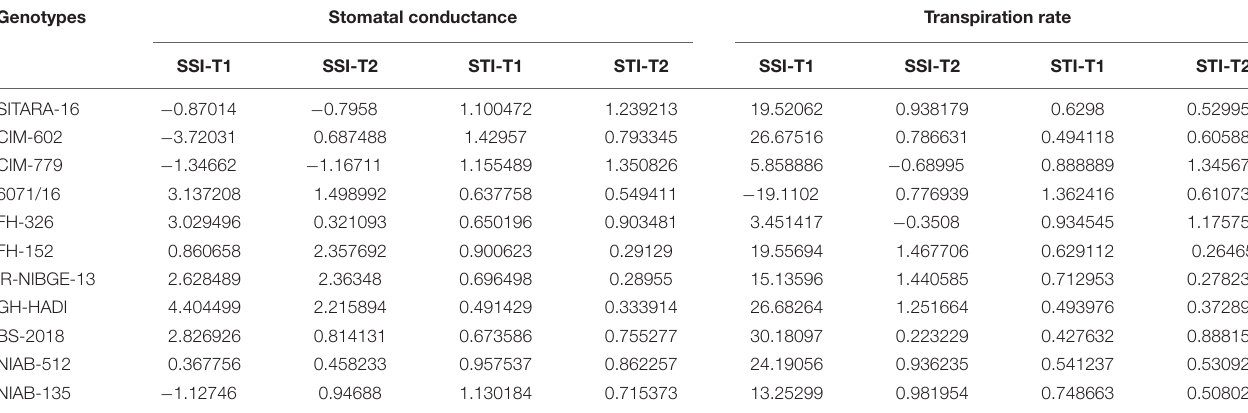
TABLE 6 | Stress susceptibility and tolerance indices for stomatal conductance and transpiration rate. Genotypes